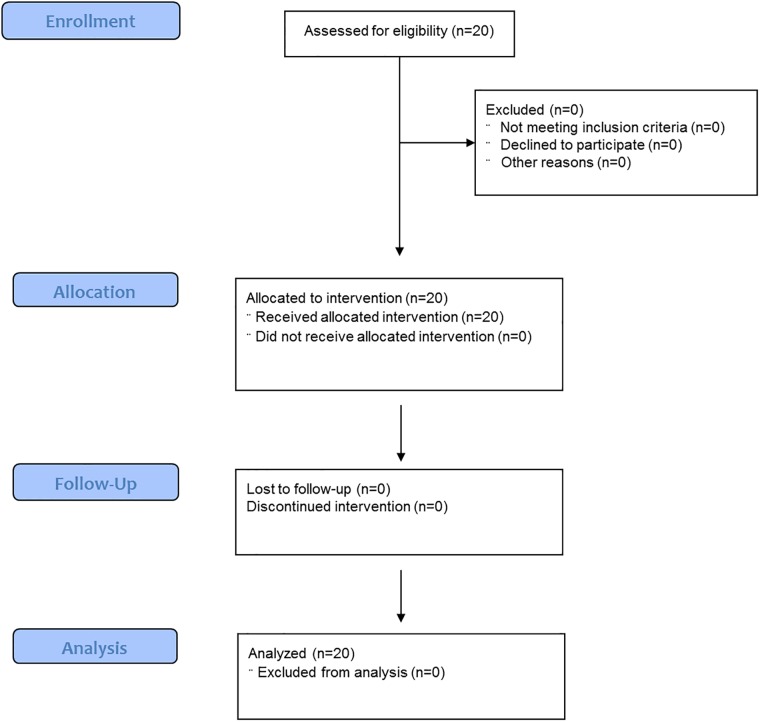
Flowchart.Adapted CONSORT flowchart for clinical trials.